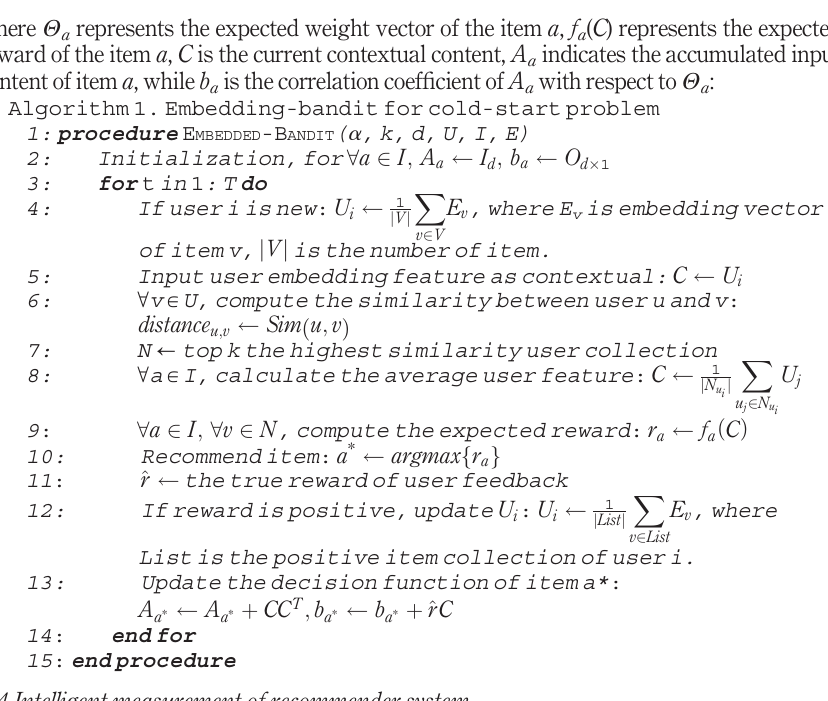
Algorithm 1. Embedding-bandit for cold-start problem 1: procedure E MBEDDED -B ANDIT ( a , k, d, U, I,